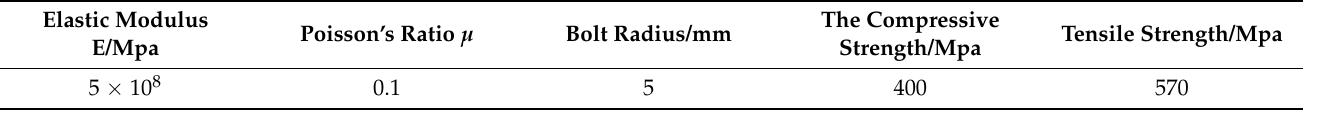
Table 1. Mechanical parameters of